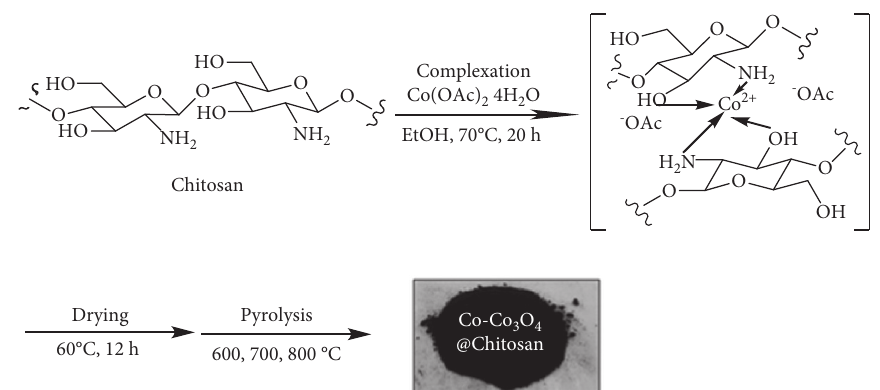
Figure 4: Synthesis of Co-Co